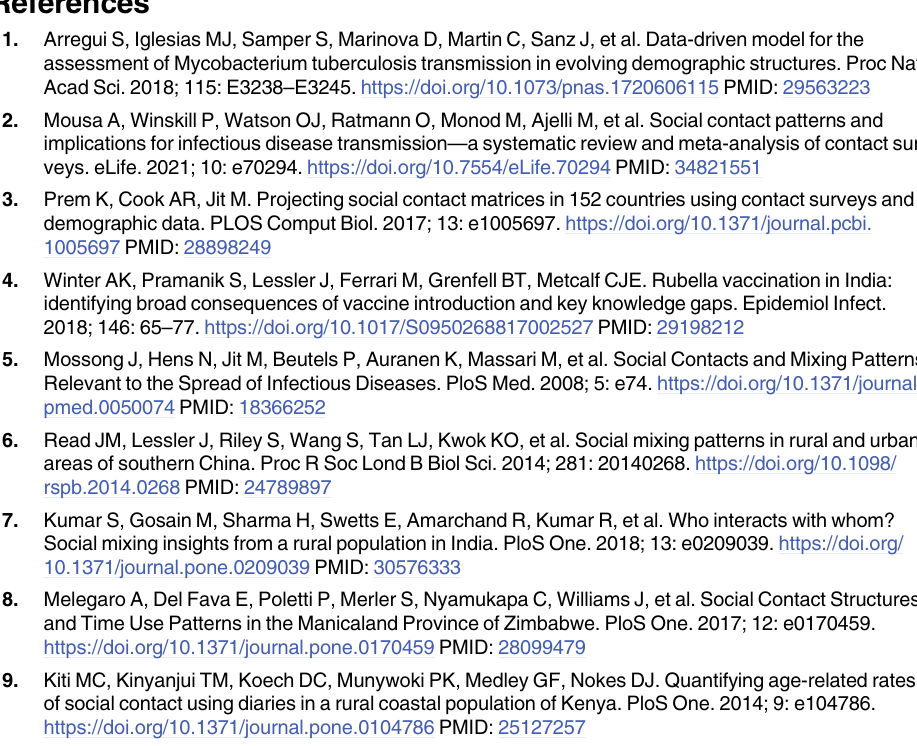
Model Parameters. Table B. Calibration Targets. Table C. Vaccine